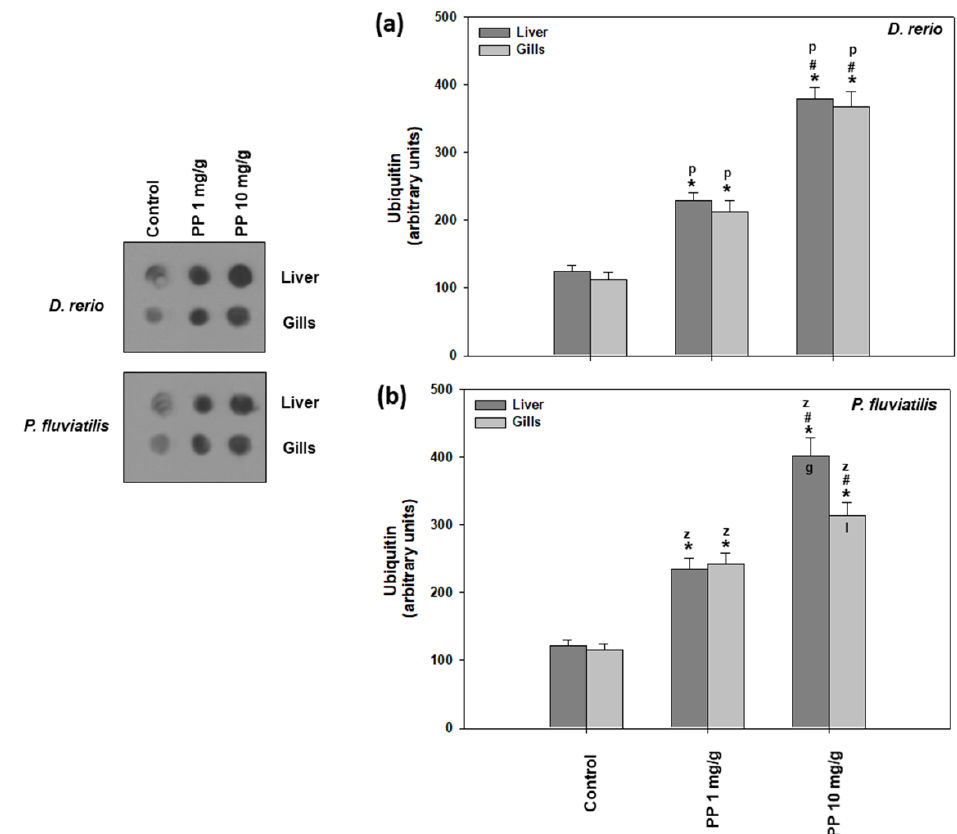
Figure 3. Ubiquitin conjugates (mean ± SD) in the liver and gills of Danio rerio ( a ) and Perca fluviatilis ( b ) , control and dietary exposed to 1 mg PP-MPs /g and 10 mg PP-MPs/g dry food. Asterisk (*) denotes significant differences ( p < 0.05) compared to the control group, dash (#) denotes significant differences ( p < 0.05) between the two examined concentrations: 1 mg PP-MPs/g and 10 mg PP- MPs/g, lower case letters “z” and “ p ” denote significant differences ( p < 0.05) between the two examined species D. rerio and P. fluviatilis, respectively, while lower case letters “g” and “l” denote within species significant differences ( p < 0.05) between the gills and liver, respectively.